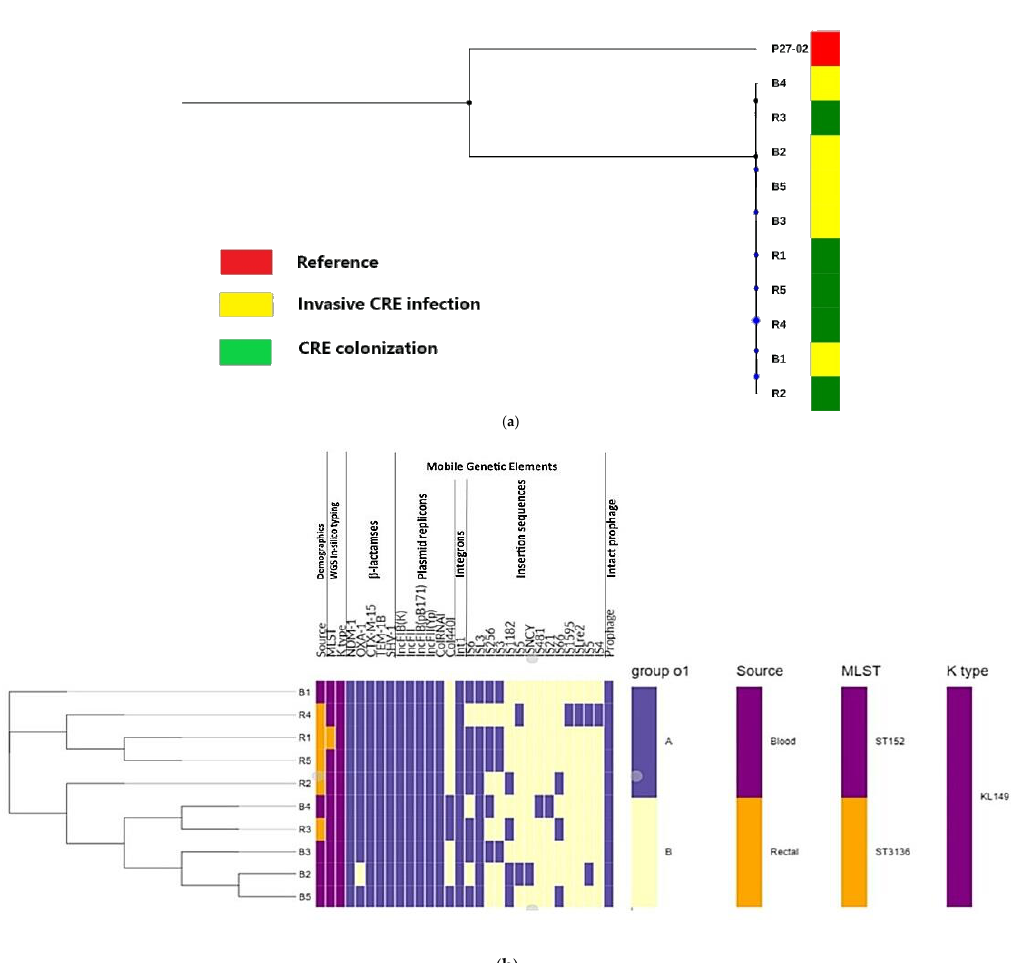
Figure 2. ( a ): A phylogenomic tree based on the single nucleotide polymorphism (SNPs) differences from whole genomes of the 10 carbapenem resistant-K. pneumoniae isolates. The K. quasi-pneumoniae strain P27-02 (accession number: NXHG00000000.1) was rooted and used as the outgroup in the tree. The bootstrap values (in blue dots) for the nodes have been indicated on the tree. The tree depicted a major clade with the node showing the slight differentiation of the isolates in the phylogenetic tree. The scale bar represents one nucleotide substitution per 1000 sequence positions. ( b ): The core genome phylogenetic branch and metadata (demographics; WGS in- silico typing; β -lactamases, plasmid replicons, integrons, insertion sequences, and intact prophages) coupled by the use of Phandango (https://github.com/jameshadfield/phandango/wiki) in isolated carbapenem resistant- K. pneumoniae strains ( n = 10) from the public hospital in South Africa. The color codes for β -lactamases, plasmid replicons, integrons, insertion sequences and intact prophages (10) showed presence (light blue; A) and absence (yellow; B) in the isolates.